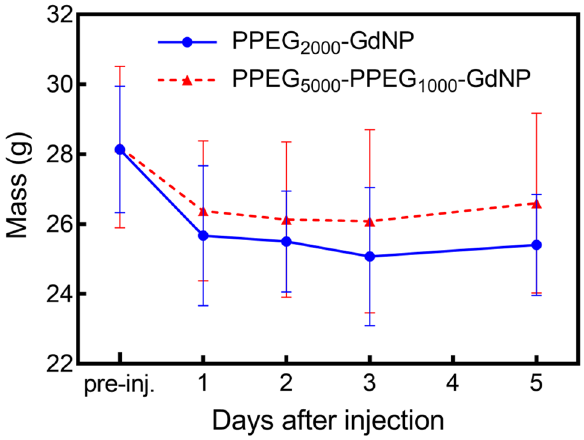
Figure 6. Effect of the contrast-agent injection procedure on subject mass.